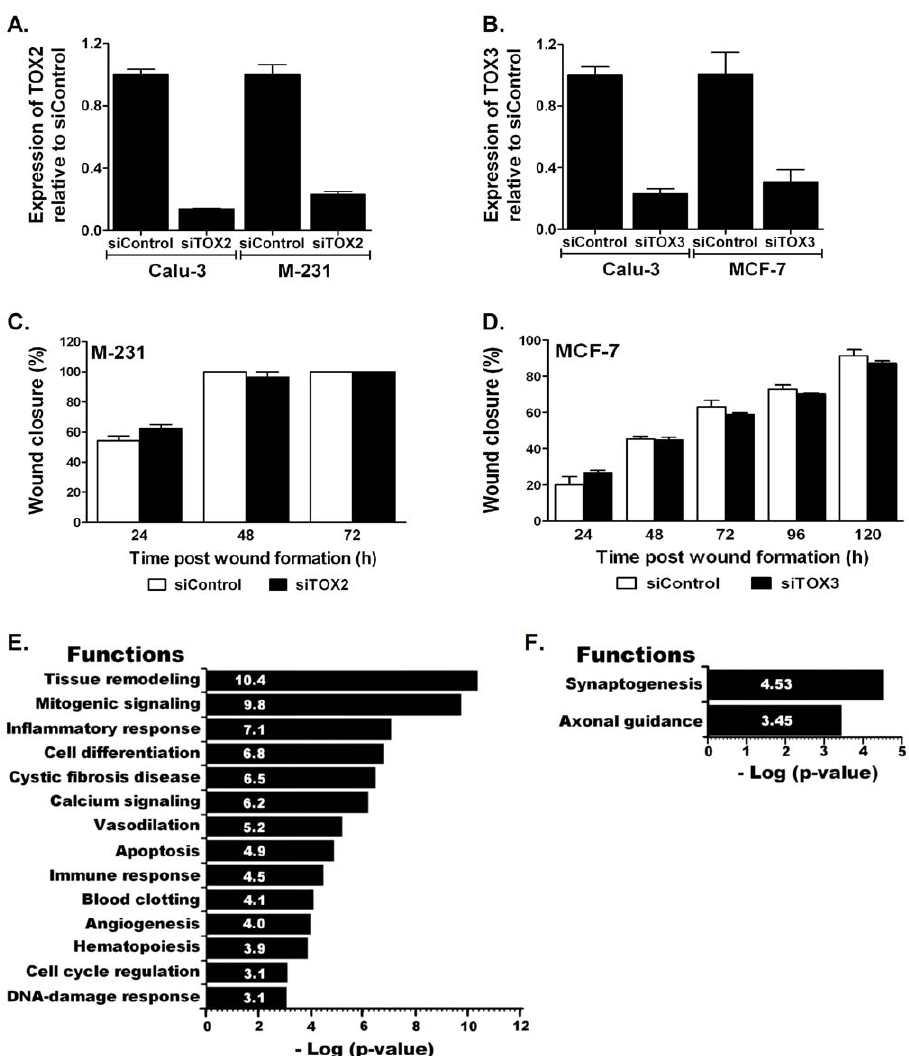
Figure 5. Genome-wide impact of epigenetic inactivation of TOX2 and TOX3 . Transfection of ( A ) Calu-3 and MDA-MB-231 (M-231) with siRNAs targeting TOX2 ( siTOX2 ) or ( B ) Calu-3 and MCF-7 targeting TOX3 ( siTOX3 ) reduced expression of these genes by 70–86% compared to cells transfected with control siRNA (siControl). ( C and D ) However, knockdown of these genes did not change the migration potential of these cells. Genome-wide gene expression assays comparing Calu-3 cells transfected with ( E ) siControl vs. siTOX2 or ( F ) siControl vs. siTOX3 revealed genes and pathways modulated by epigenetic inactivation of these genes.